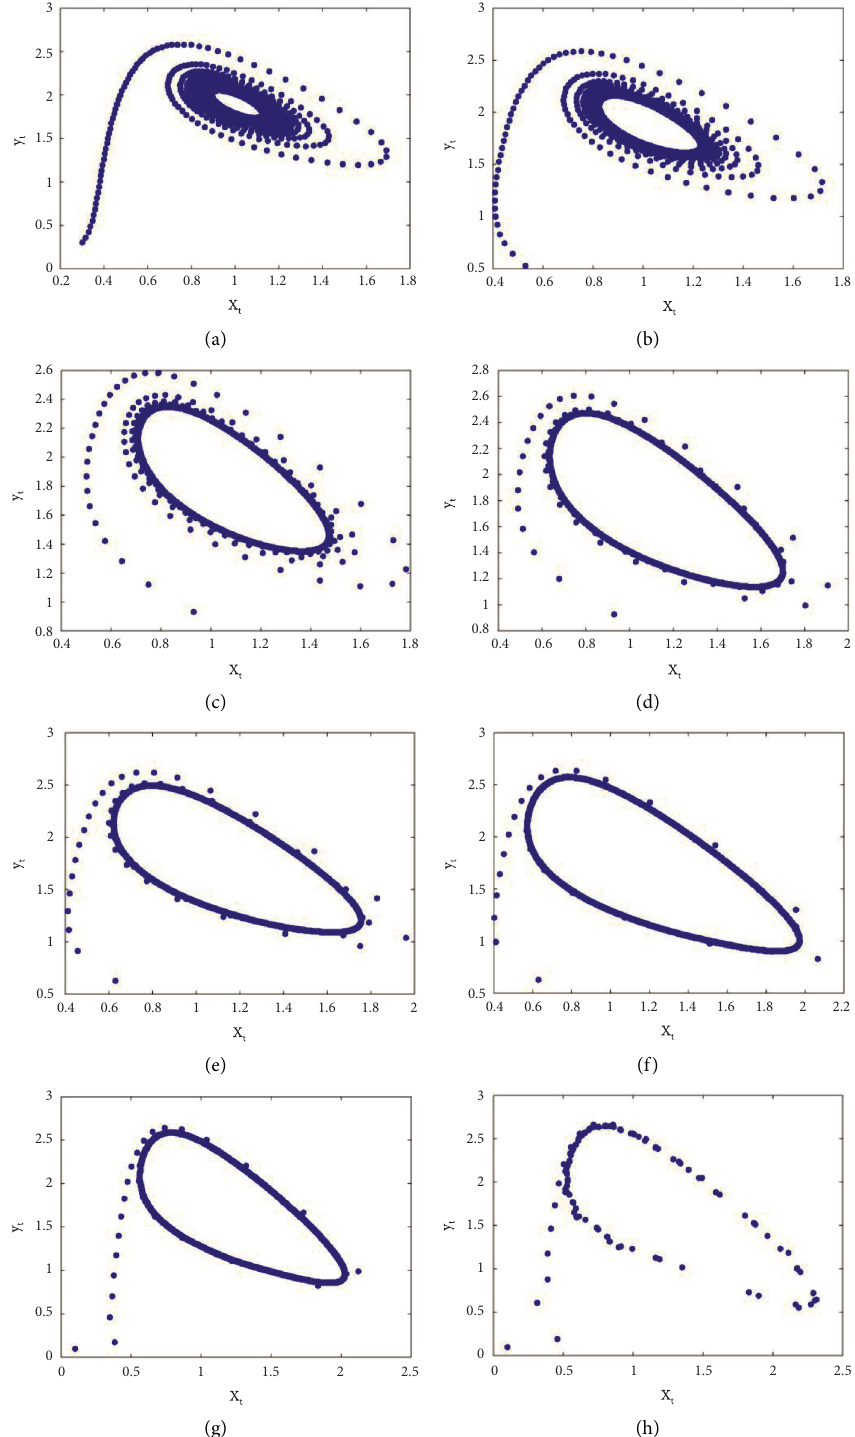
Figure 2: An unstable focus of the Brusselator system (10). (a) h � 0.11 with (0.3, 0.3), (b) h � 0.13 with (0.53, 0.53), (c) h � 0.2 with (0.93, 0.93), (d) h � 0.28 with (0.93, 0.93), (e) h � 0.3 with (0.63, 0.63), (f) h � 0.38 with (0.63, 0.63), (g) h � 0.4 with (0.63, 0.63), and (h) h � 0.5 with (0.1,